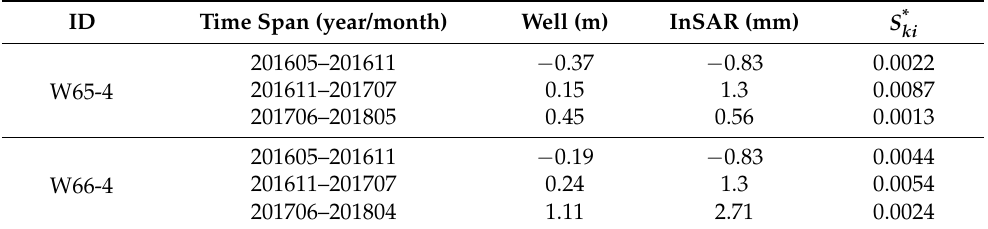
Table 3. Elastic and inelastic skeleton release coefficients determined by InSAR deformation and groundwater level